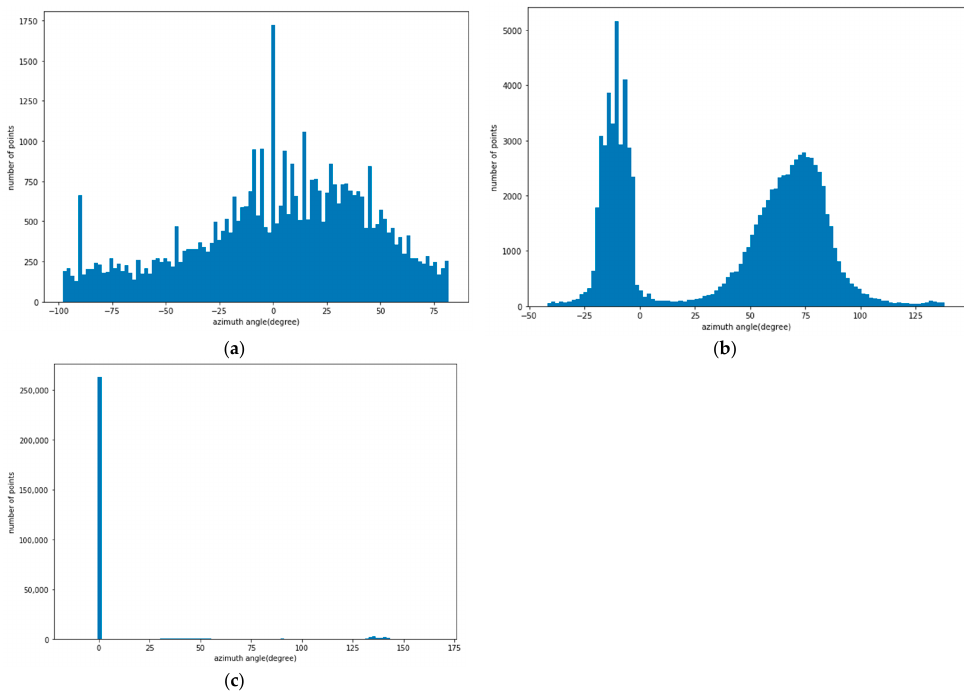
Figure 9. Azimuth angle distribution of points; ( a ) Concrete panel; ( b ) Soil mixing wall; ( c ) Sheet pile.